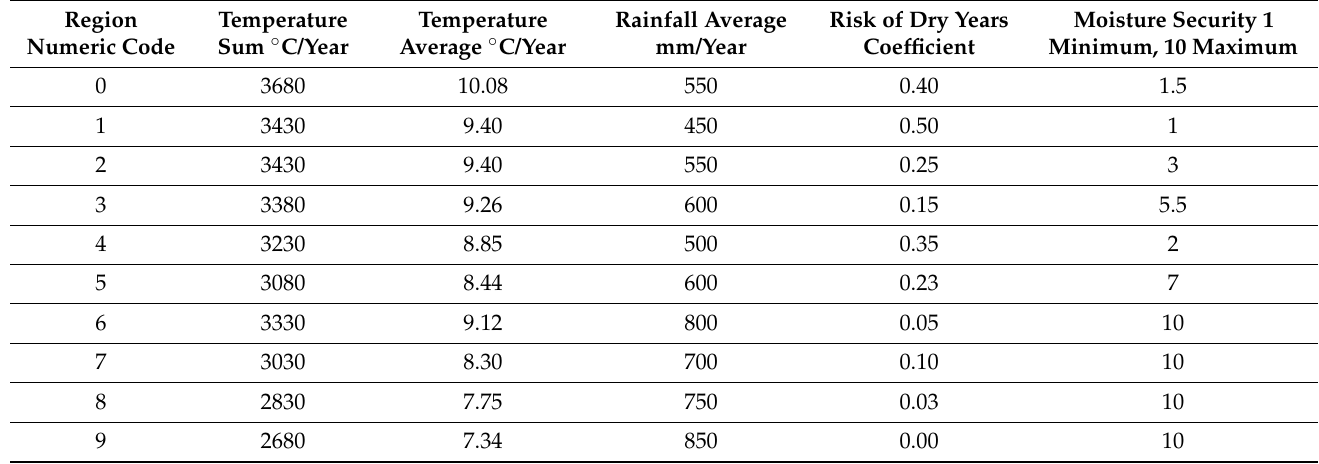
Table A7. Description of the climatic regions.